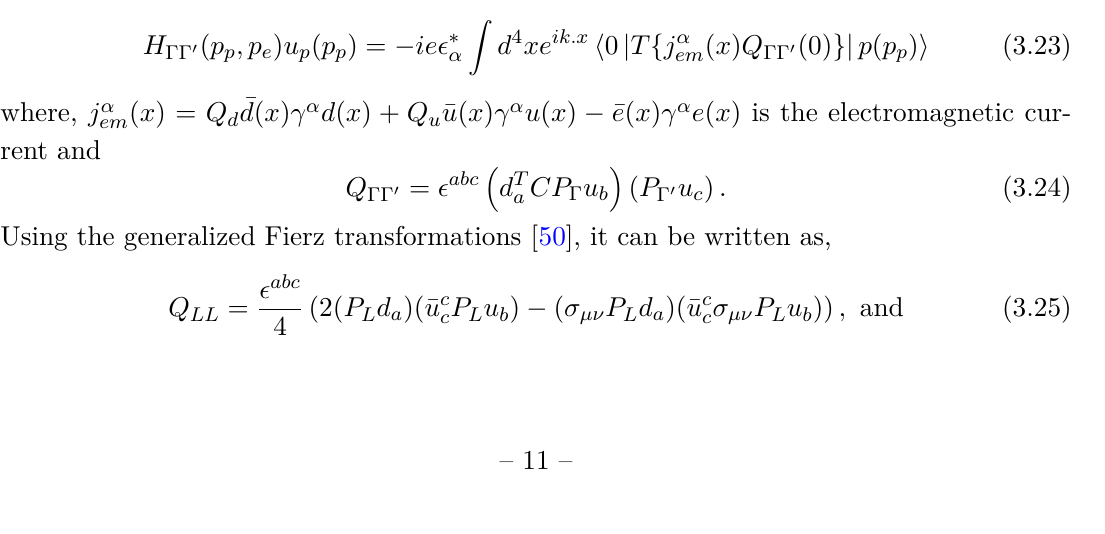
Figure 7 . The physical FF, A TP + KPP panel) vs P 2 are shown at s e associated with the parameters involved in photon DAs. The bands represents the